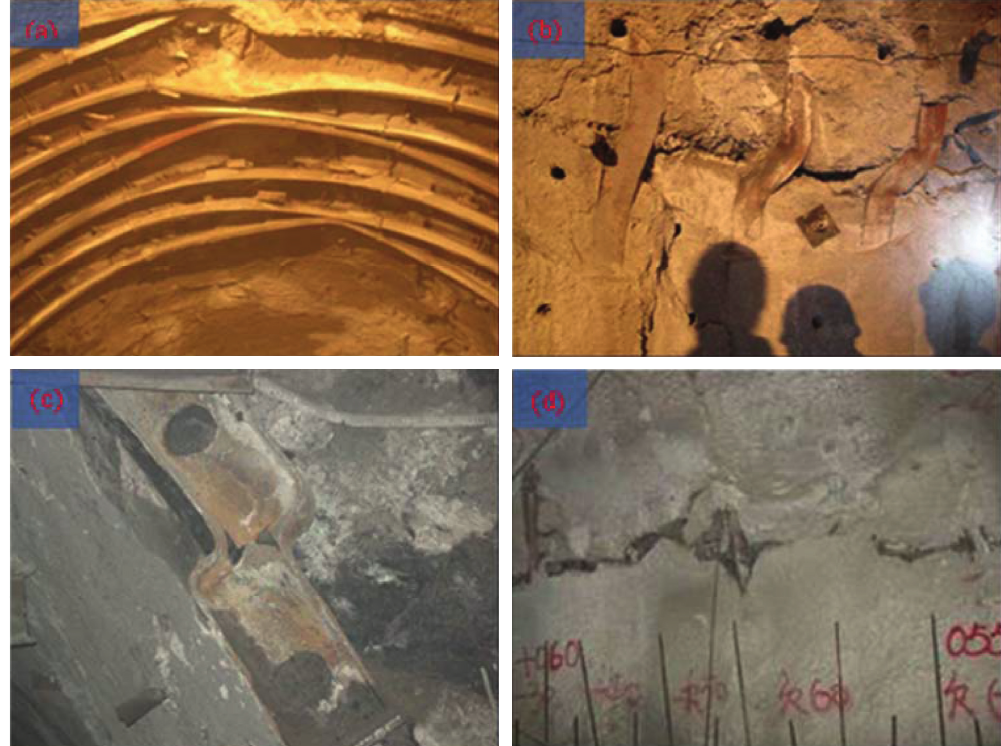
Figure 1: Different forms of tunnel damage: (a) the tunnel support arch being twisted; (b) tunnel lining destruction; (c) tunnel lateral wall destruction; and (d) tunnel lateral wall